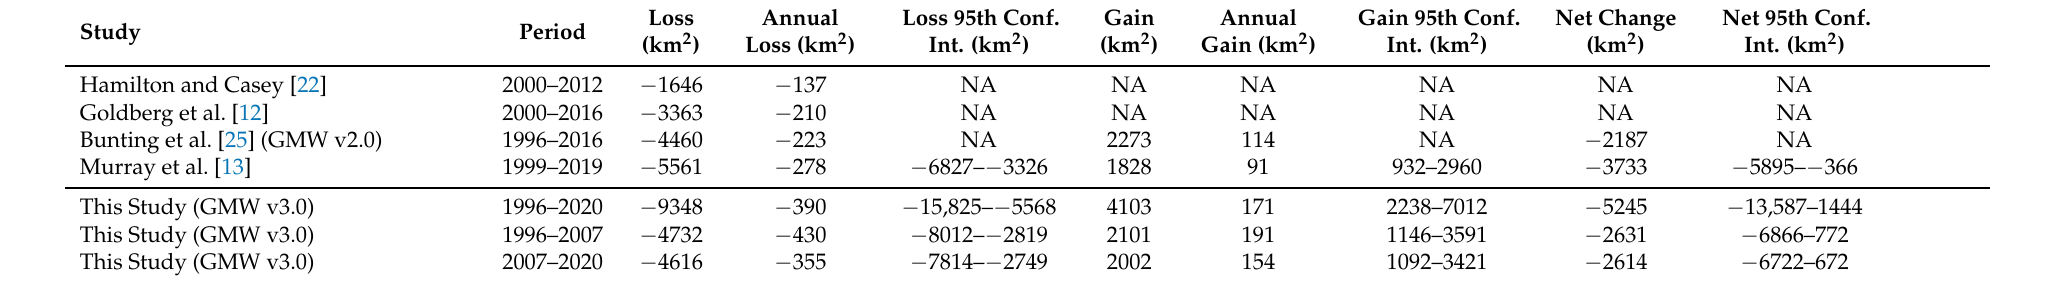
Table 11. Comparison of the results of this study to other global estimates of mangrove change. Note: reported GMW v3.0 mangrove change estimates account for known map commission and omission